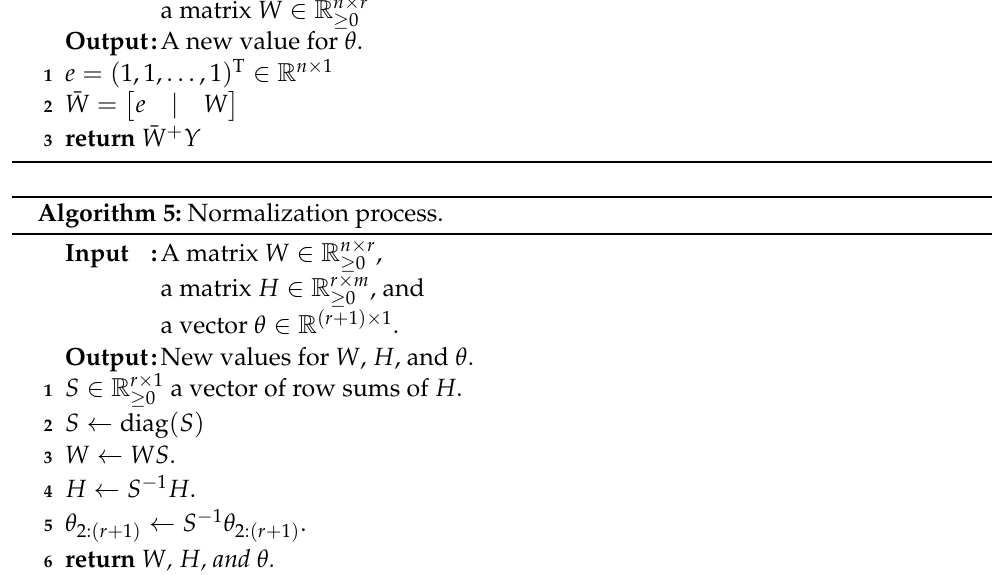
Algorithm 4: Updating θ .